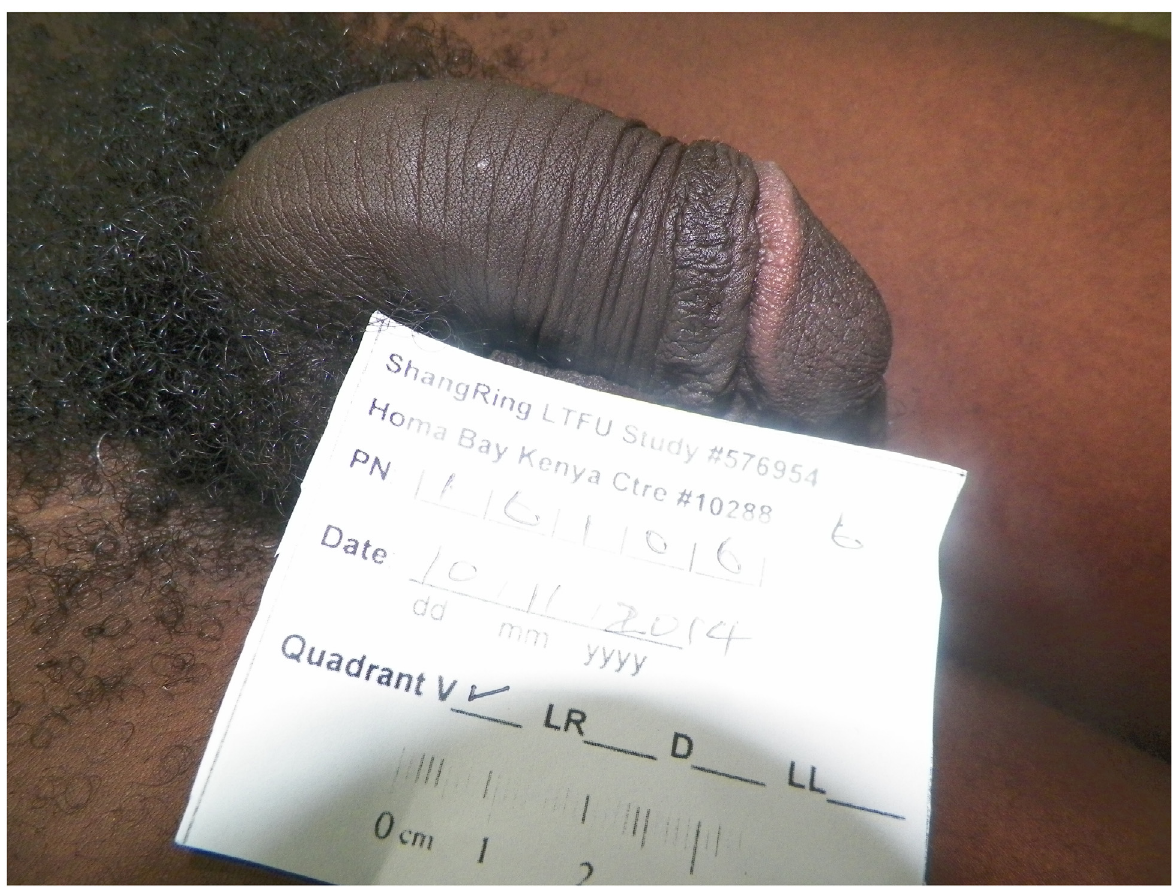
Fig 1. Typical Penile Appearance at Longer-term